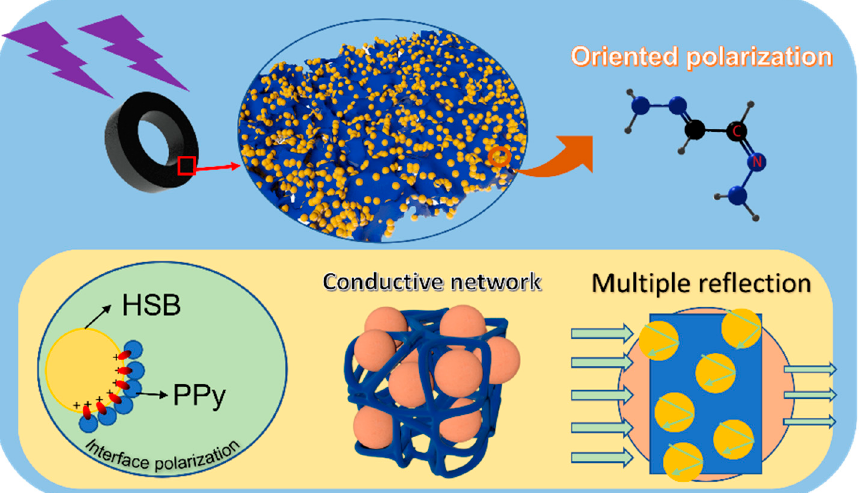
Figure 10. Schematic diagram of the electromagnetic absorption mechanism of PPy/HSB composite.